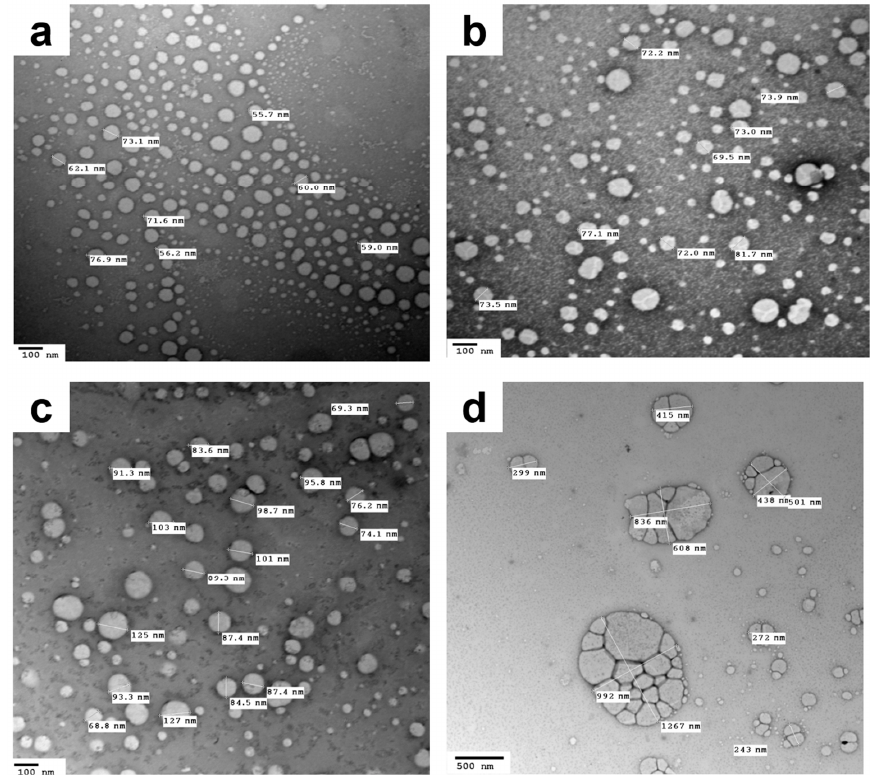
Figure 3. TEM images demonstrating the dispersed phase of the 50-fold saline-diluted NEs of ( a ) C3 TD , ( b ) C4 TD and ( c , d ) P2 TD after nebulization.